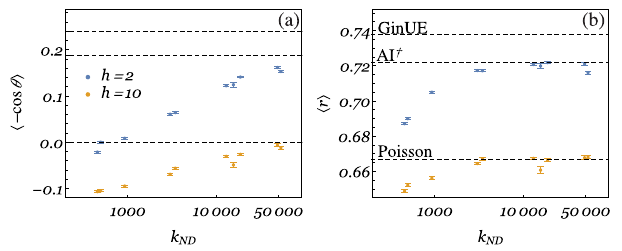
FIG. 10. Finite-size effects on the complex spacing ratios of the non-Hermitian Hamiltonian of Eq. (13), in the delocalized (blue) and localized (orange) regimes. We consider different chain lengths N and particle-number sectors D , the sector dimension N being k Þ . (a) Average value of cos θ ; (b) average value of ND ¼ ð D r . The upper, middle, and lower dashed lines correspond to the large- N GinUE, AI † , and Poisson limits,